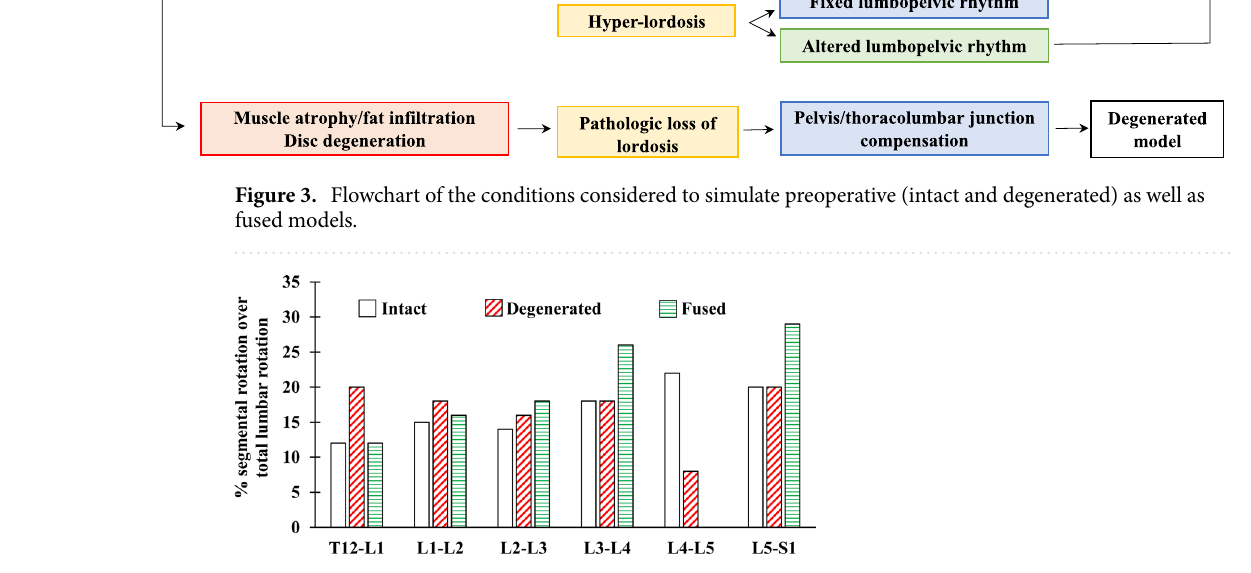
Figure 4. Relative contribution of different lumbar segments to the total lumbar flexion in the intact, degenerated, and fused